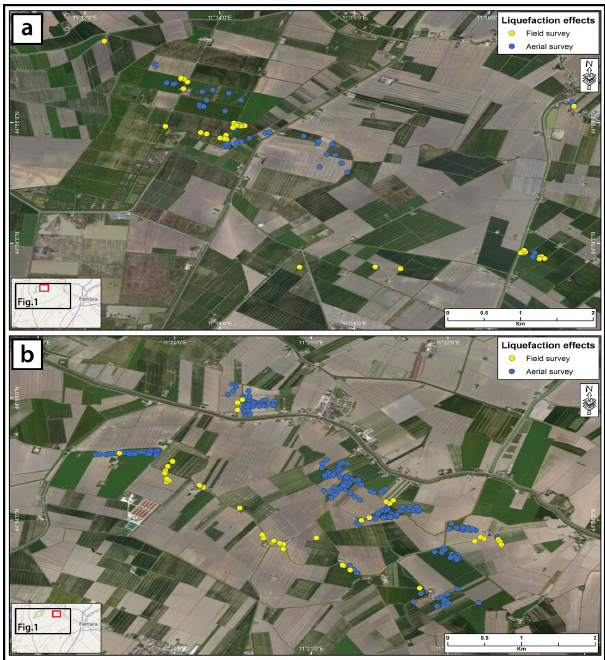
Figure 3. Subset of the 2012 Emilia sequence liquefaction effects (from both field and aerial surveys) showing their arrangement in clusters and rectilinear or meander-like alignments.